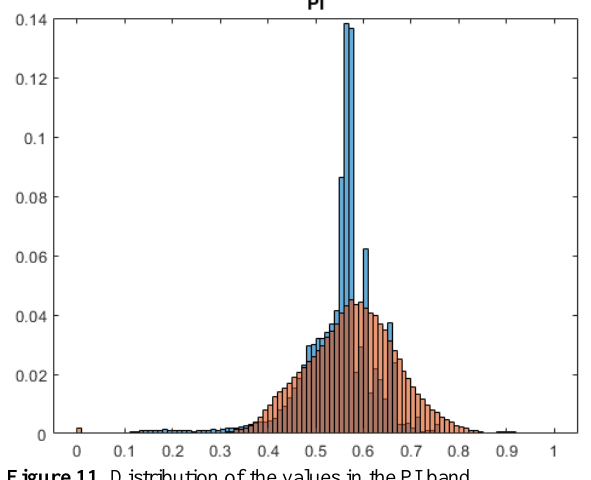
Figure 11. Distribution of the values in the PI